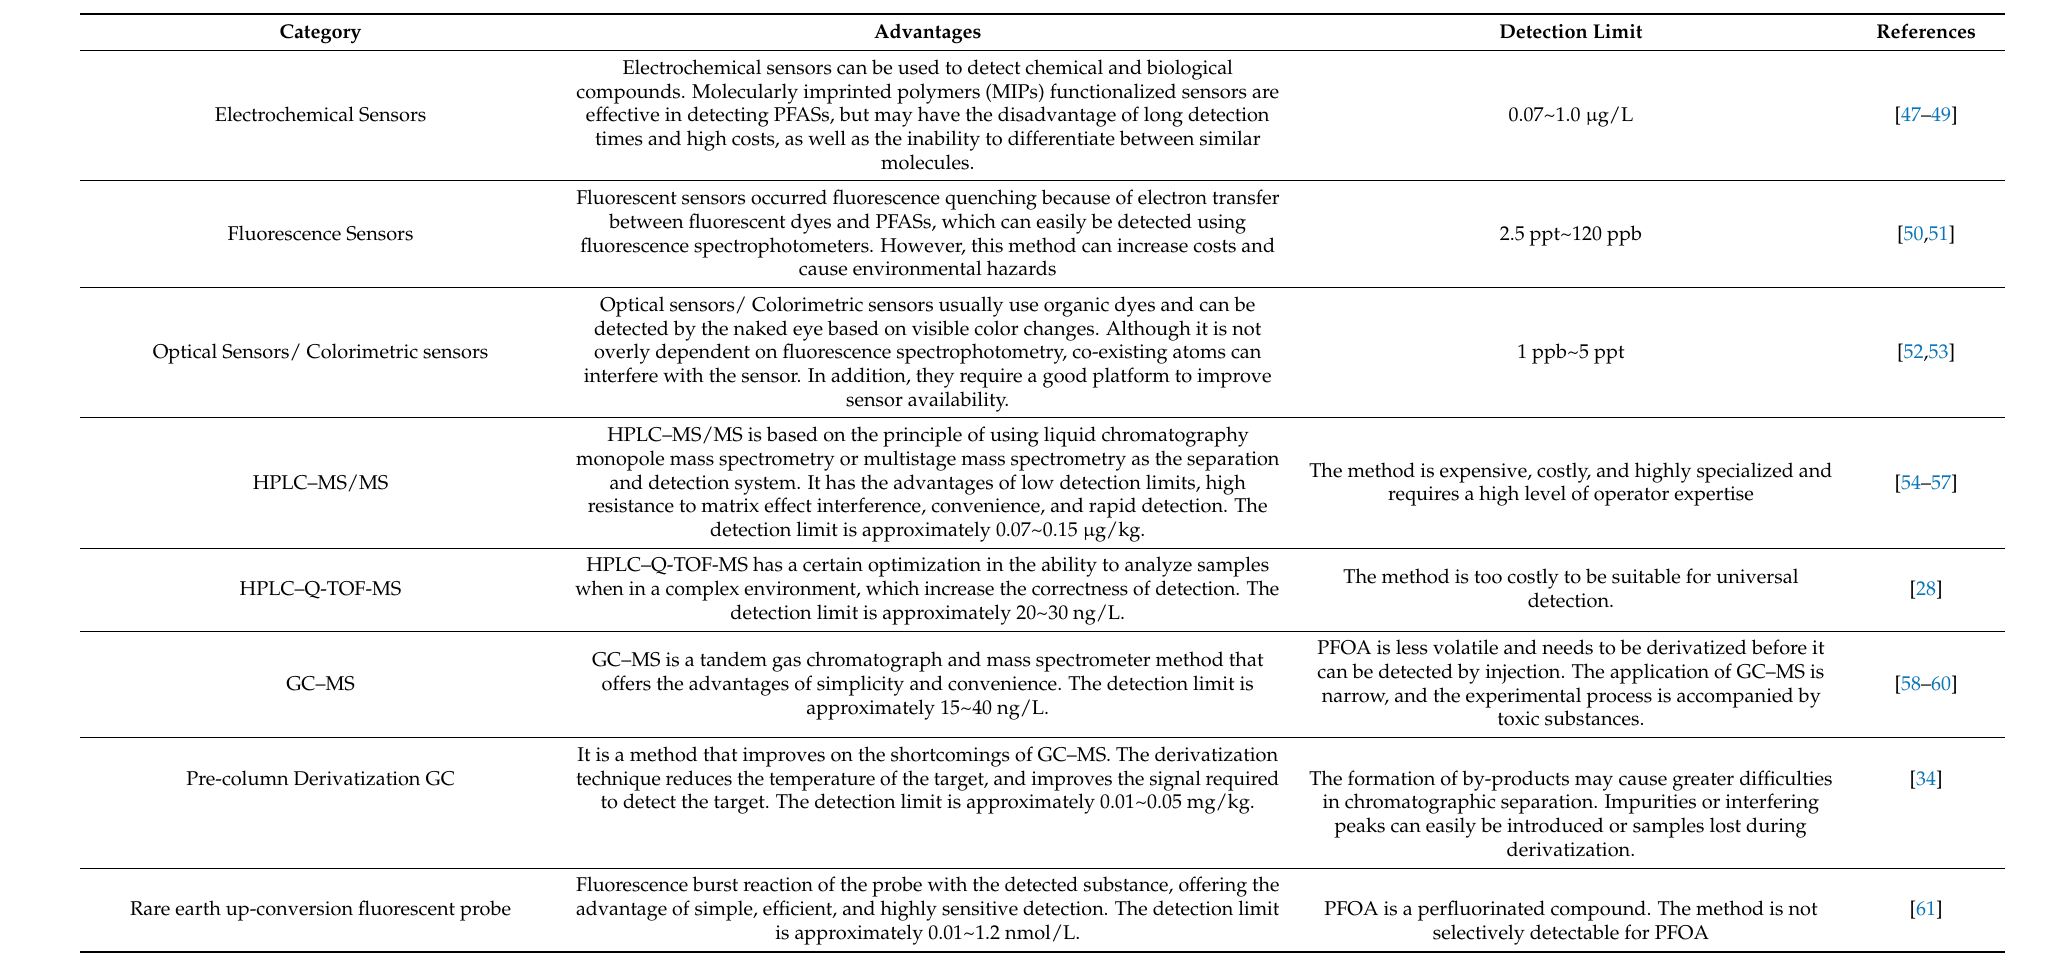
Table 2. Advantages and disadvantages of detection